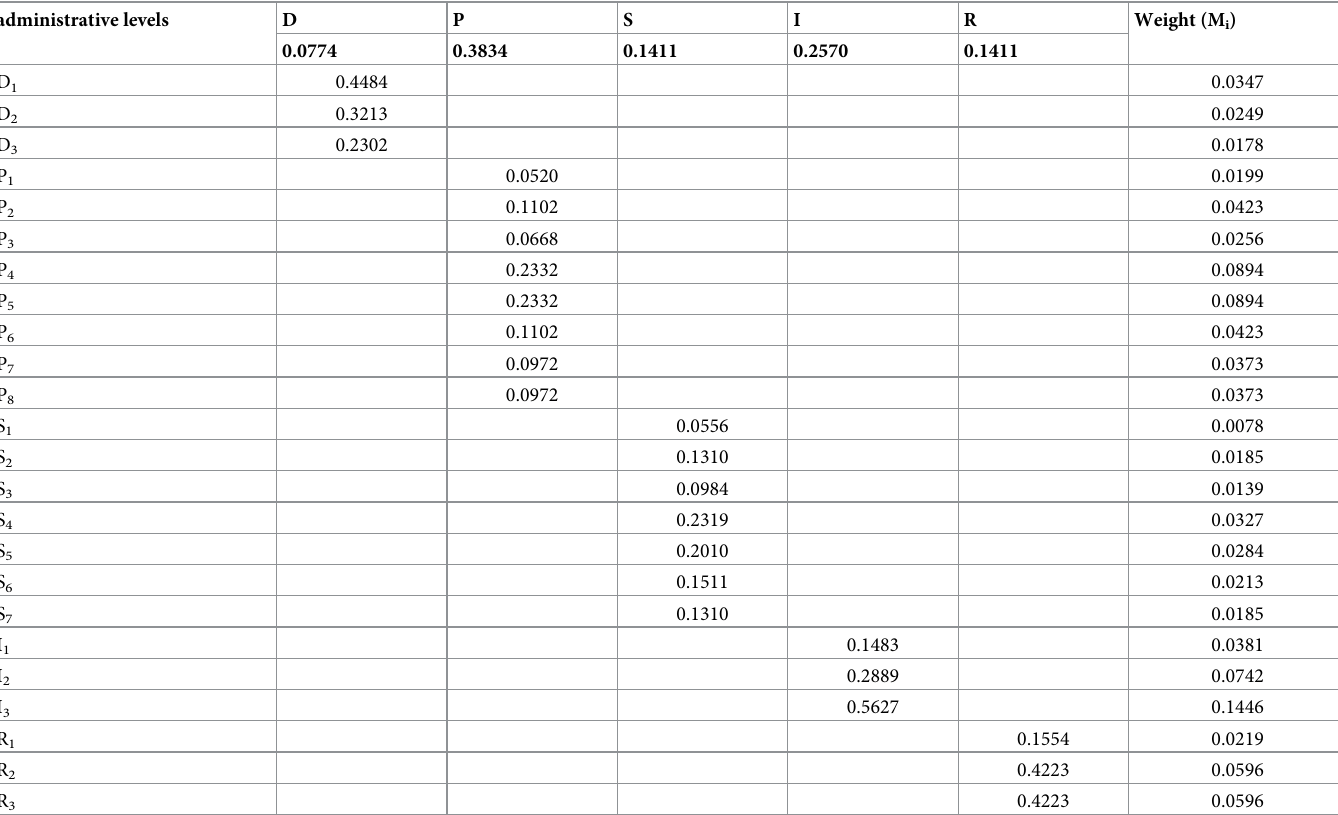
Table 8. Individual and total rankings of land-based ecological security index levels in Xingtai. administrative